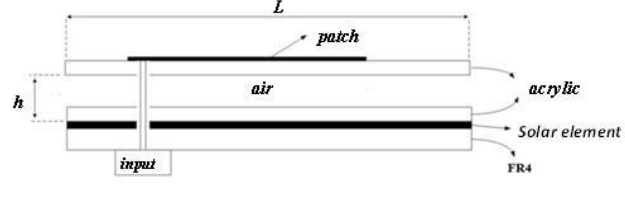
Fig. 1 . The radiator on the surface of the